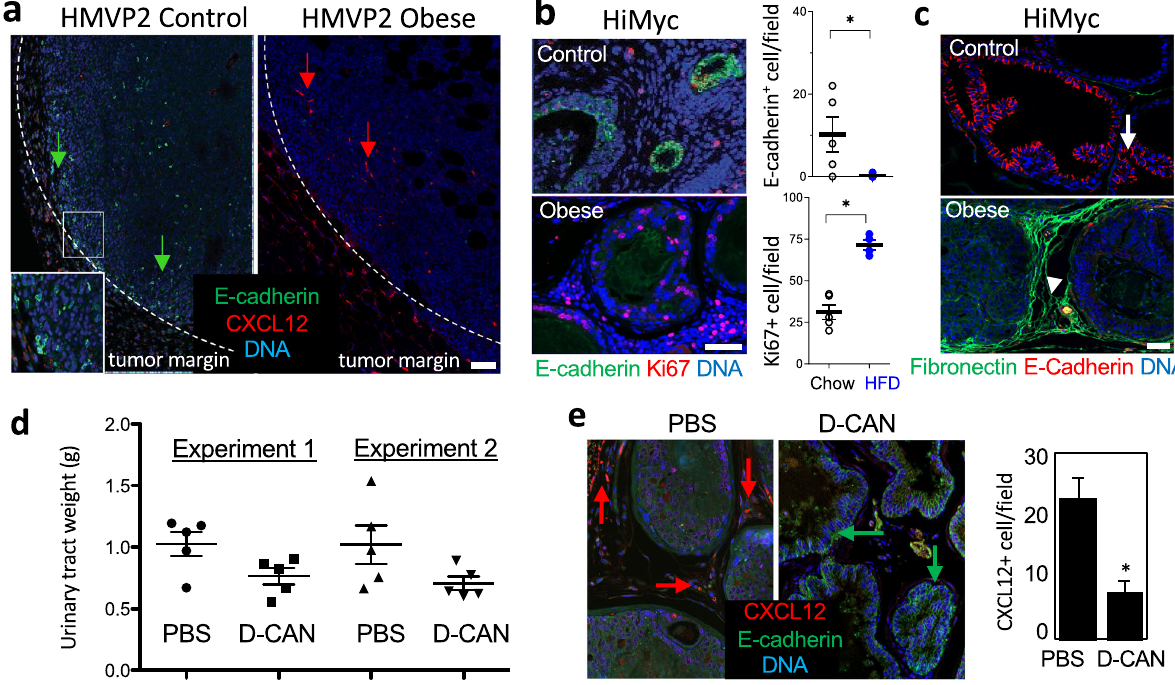
Fig. 1 ASC recruitment in obesity is linked with EMT and CXCL12 expression. a FVB mice pre-fed low-fat or high-fat diet to induce DIO were grafted with HMVP2 spheroids. Representative resected tumors were analyzed for CXCL12 and E-Cadherin (arrows) in tumor sections. Note membrane E-cadherin (inset: high magni fi cation) and its loss (indicating EMT) concomitant with CXCL12 expression in DIO. b IF on sections of ventral prostates of 6-month-old HiMyc mice fed chow (control) or HFD (obese) reveals proliferation (Ki67 + ) in tumor cells lacking E-cadherin in obesity. Quanti fi cation of IF data (based on counts from N = 5 view fi elds) from mice raised on chow and HFD is graphed on the right. c IF on sections of ventral prostates of control and obese HiMyc mice (9 months old). E-cadherin in prostate epithelium (arrow) is downregulated in DIO mice concomitantly with fi bronectin induction in the stroma (arrowhead). d HiMyc mice maintained on HFD treated with D-CAN starting at 12 weeks of age for 4 weeks and terminated at 16 (experiment 1) or 24 (experiment 2) weeks of age have lower urinary tract weight, compared to control mice treated with PBS. N = 5. e IF analysis of ventral prostate of mice from d . Note induction of E-cadherin in epithelium concomitant with reduction of CXCL12 in the stroma, indicating EMT reversal upon D-CAN treatment. Graph: quanti fi cation of CXCL12 + cells in the stroma in ( e ); N = 5. For all panels, * P < 0.05 compared to control (Student ’ s t test). Scale bar = 100